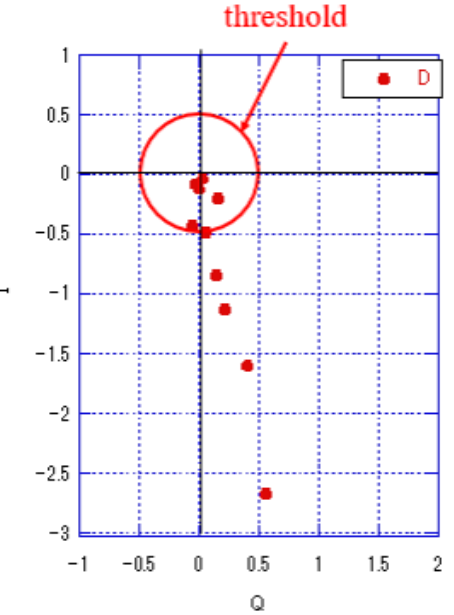
Figure 7. Receiver-side processing ("D" indicates the received signal